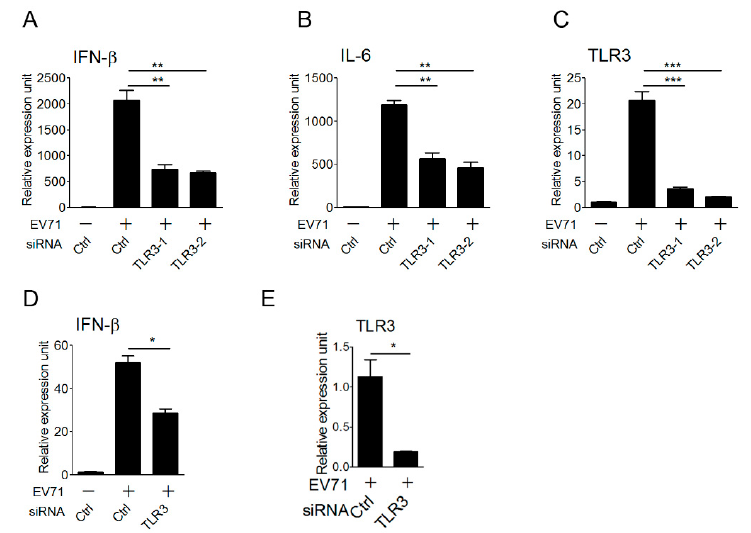
Figure 4. TLR3 senses EV-A71 infection in primary macrophages and dendritic cells. (A, B, and C) Mouse bone marrow-derived macrophages (BMMs) transfected with control siRNA or two different TLR3 siRNAs were infected with EV-A71 (MP4 strain, MOI, 3) for 6 h, and then mRNA expression levels of Ifnb (A), Il6 (B), and Tlr3 (C) genes were measured using qRT–PCR. ** p < 0.005 and *** p